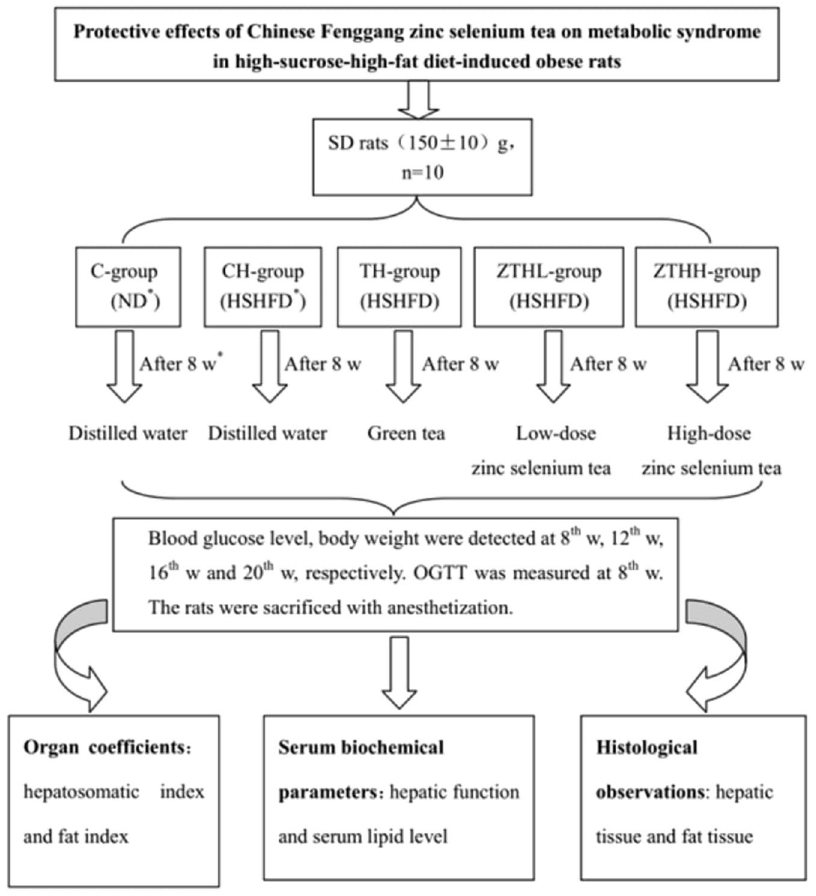
Figure 1. Exposure flow chart. (ND: normal-diet, HSHF: high-sucrose-high-fat diet, W: